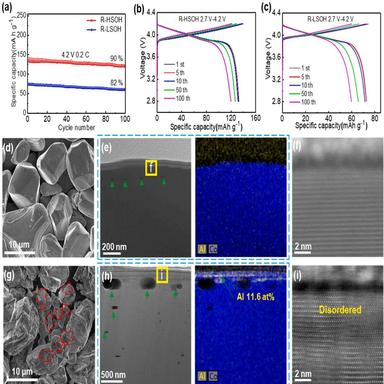
Electrochemical performance and structural comparison of the directly regenerated LCO with different SOH. (a-c) Capacity retentions and charge/discharge curves of the R-HSOH and the R-LSOH samples after 100 cycles at 2.7–4.2 V. (d) SEM image of the R-HSOH sample. (e) STEM-HAADF image of the R-HSOH sample and its corresponding EDS elemental mapping (Al, Co). Green arrows highlight the nano-scale voids. EDS results shows no Al impurity. (f) High-resolution STEM-HAADF image from the surface region (marked in (